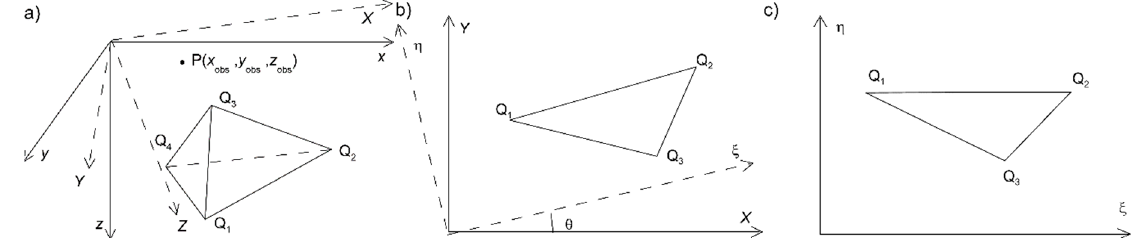
Figure A1. Process of Rotations for calculating contribution of Q1Q2: ( a ) Sketch before rotations; ( b ) Result of twice rotations; ( c ) Result of thrice rotations.